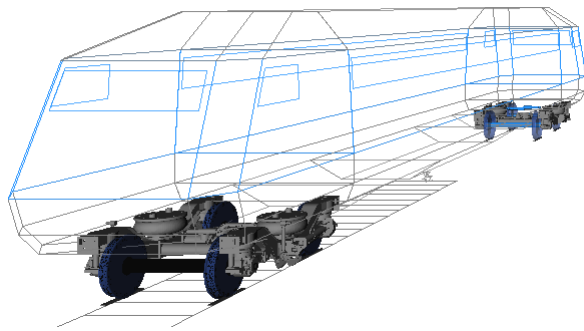
Figure 4. Simulation model.